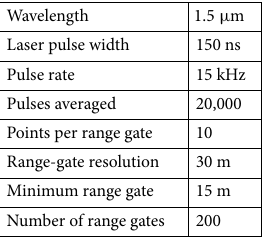
Table 2. Main technical specifications of the C1 Halo